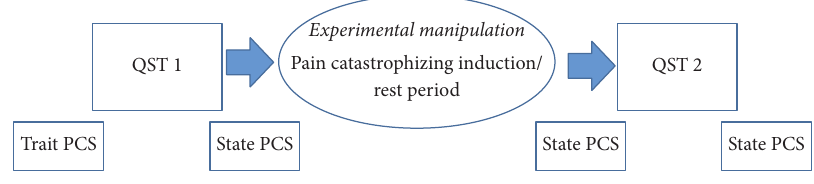
Figure 1: Schedule of events for study